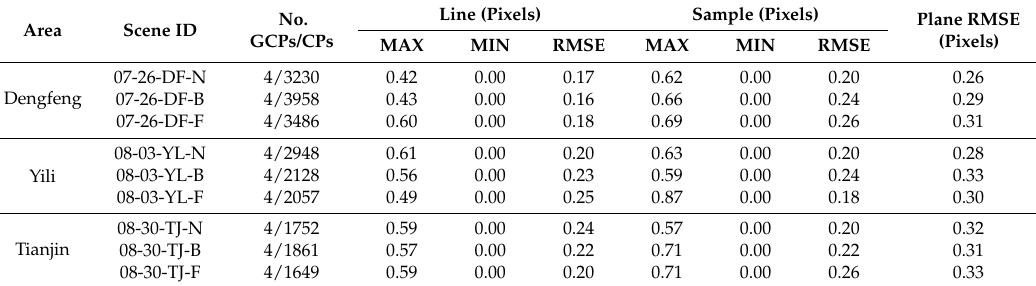
Table 7. Internal accuracy of ZY3-02 SC products.